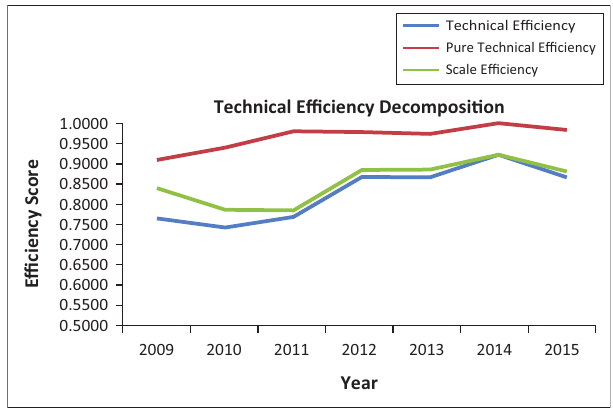
FIGURE 2: Trend of the average technical, pure technical and scale efficiency.